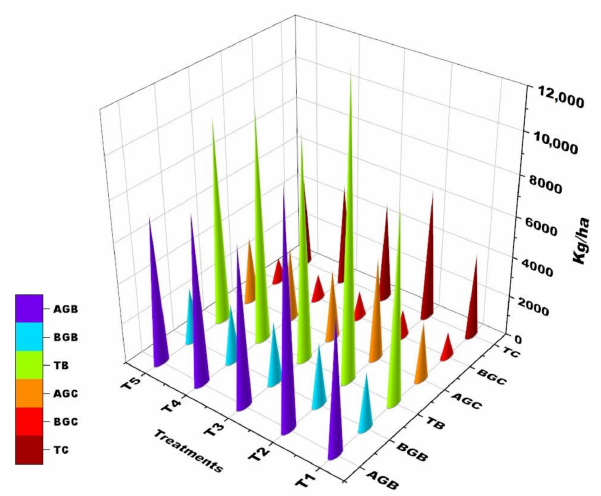
Figure 3. Soil carbon accumulation in elephant foot yam based intercropping sys- tem (AGB—aboveground biomass (kg/ha); BGB—belowground biomass; TB—total biomass; AGC—aboveground carbon (kg/ha); BGC—belowground carbon (kg/ha); TC—total carbon (kg/ha); T 1 —elephant foot yam (EFY) sole crop; T 2 —EFY + cluster bean; T 3 —EFY + radish; T 4 —EFY + Amaranthus and T 5 —EFY +